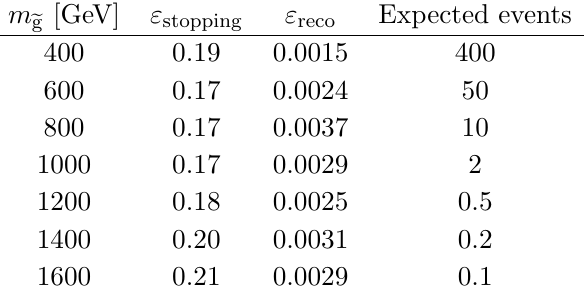
g ! qq (cid:31) 0 ) B ( (cid:31) 0 ! (cid:22) + (cid:22) (cid:0) (cid:31) 0 ) = 100%, for each mass e e e e 2 2